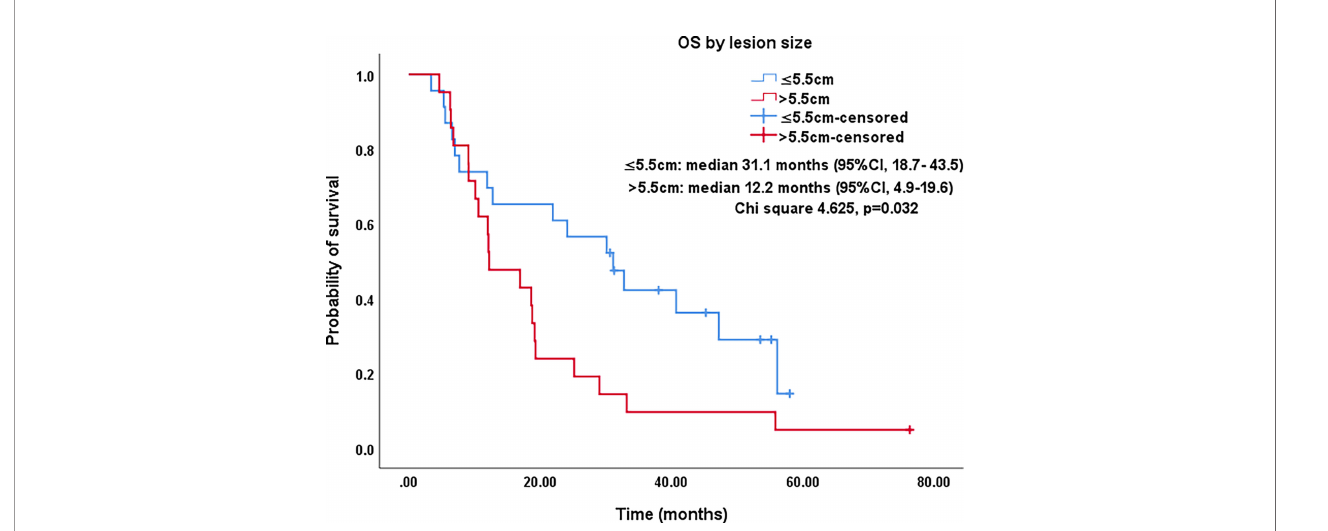
FIGURE 6 | Kaplan – Meier survival curves of OS by lesion size for all patients. The OS of lesions ≤ 5.5 cm was signi fi cantly better than that for lesions >5.5 cm (median: 31.1 months vs. 12.2 months; P=0.032). OS, overall survival; CI, con fi dence intervals.